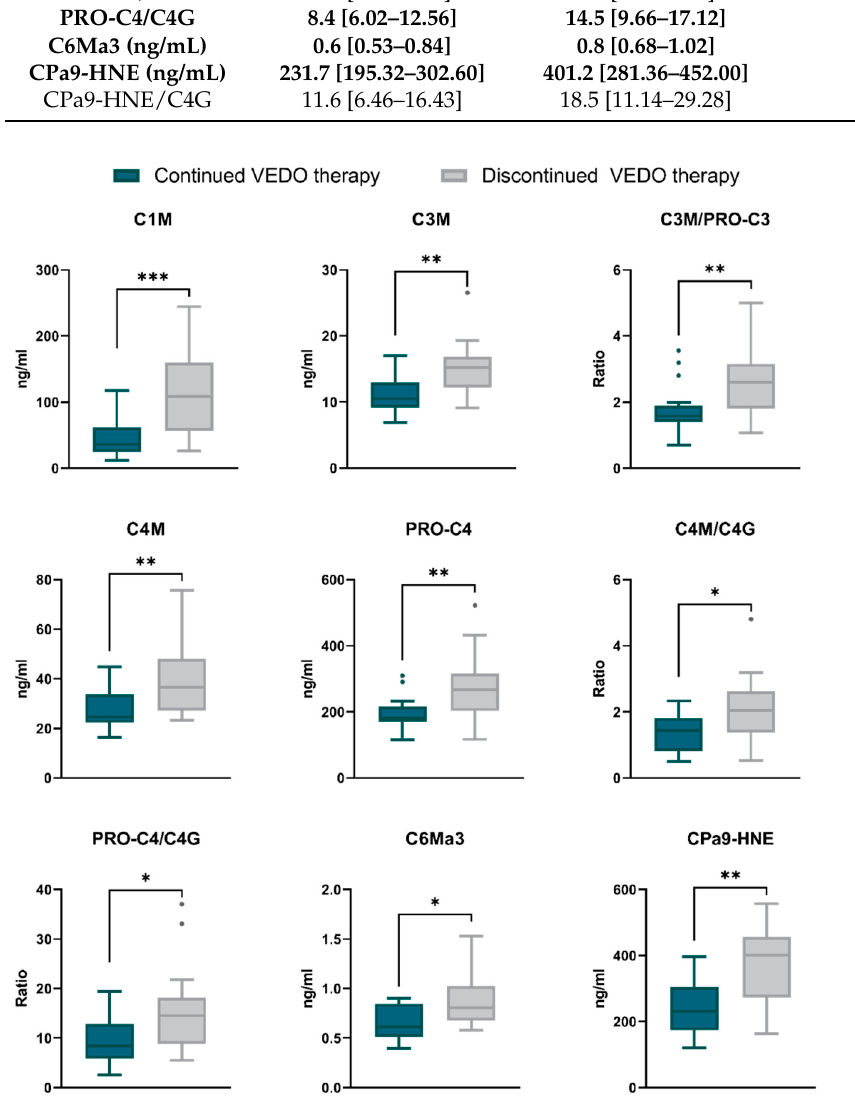
Figure 1. Baseline serum biomarker levels between patients with long-term continuation and discontinuation of VEDO treatment. Biomarker levels are presented as Tukey boxplots. * p < 0.05; ** p < 0.01; *** p < 0.001.